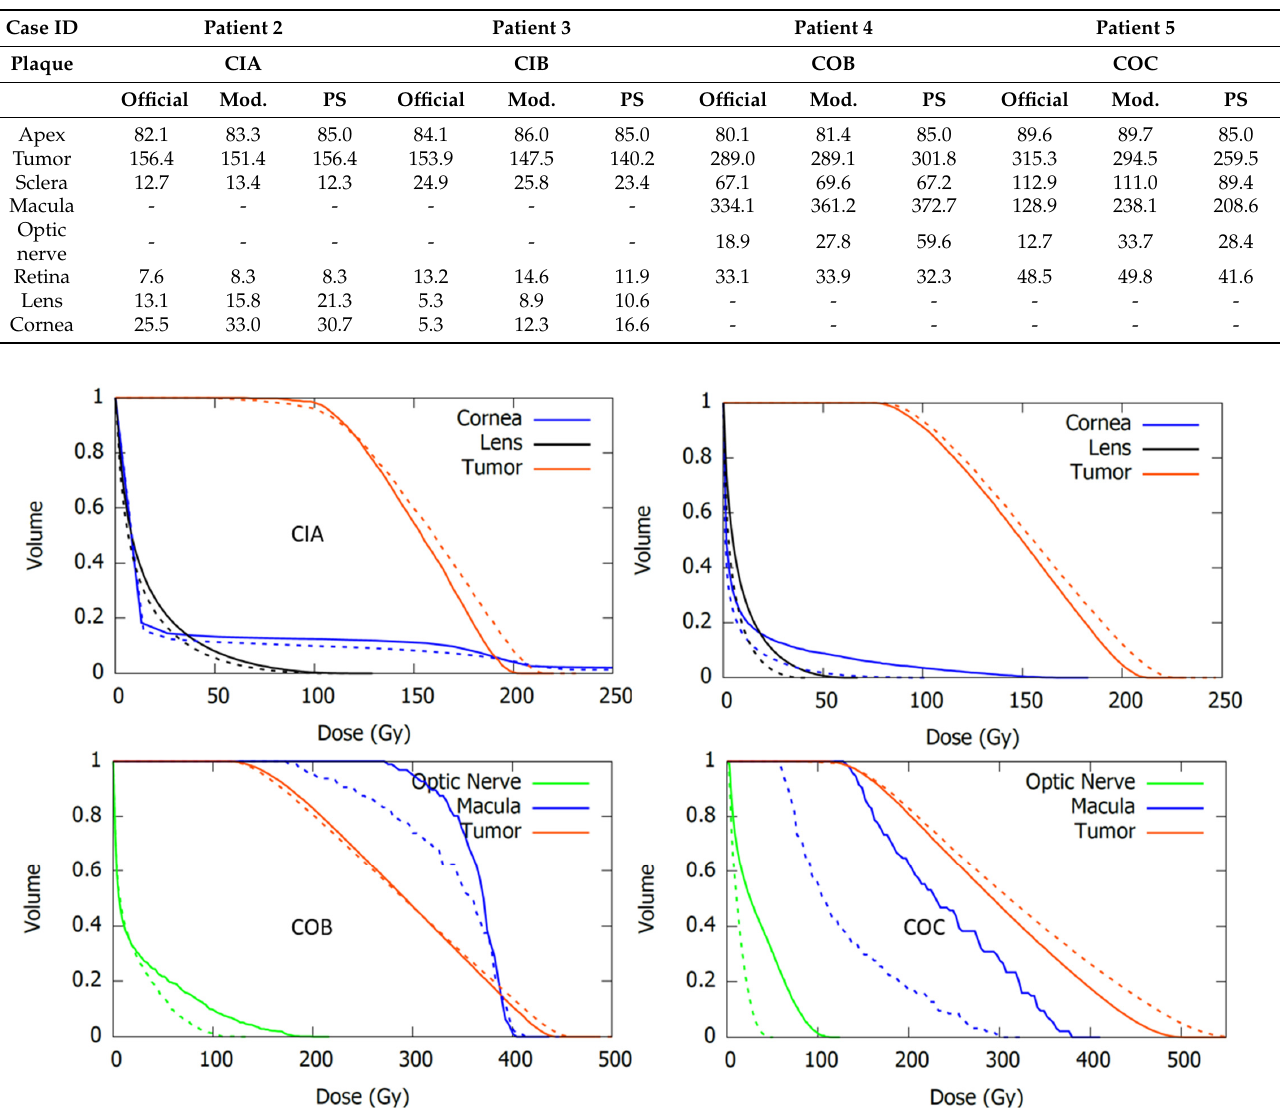
Figure 9. Dose-volume histogram curves for the tumor and the critical structures resulting from real clinical cases calculated with EyeMC using the official (dotted lines) and the modified (continuous lines) geometric models for the asymmetric applicators CIA ( upper-left ), CIB ( upper-right ), COB ( bottom ‐ left ), and COC ( bottom ‐ right ).